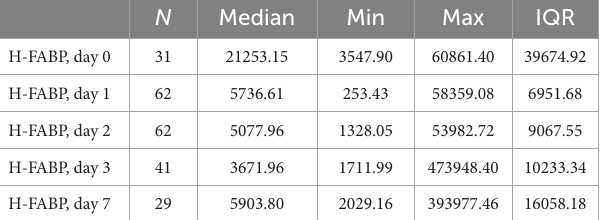
TABLE 3 Levels of H-FABP in days 0–7 within the study cohort